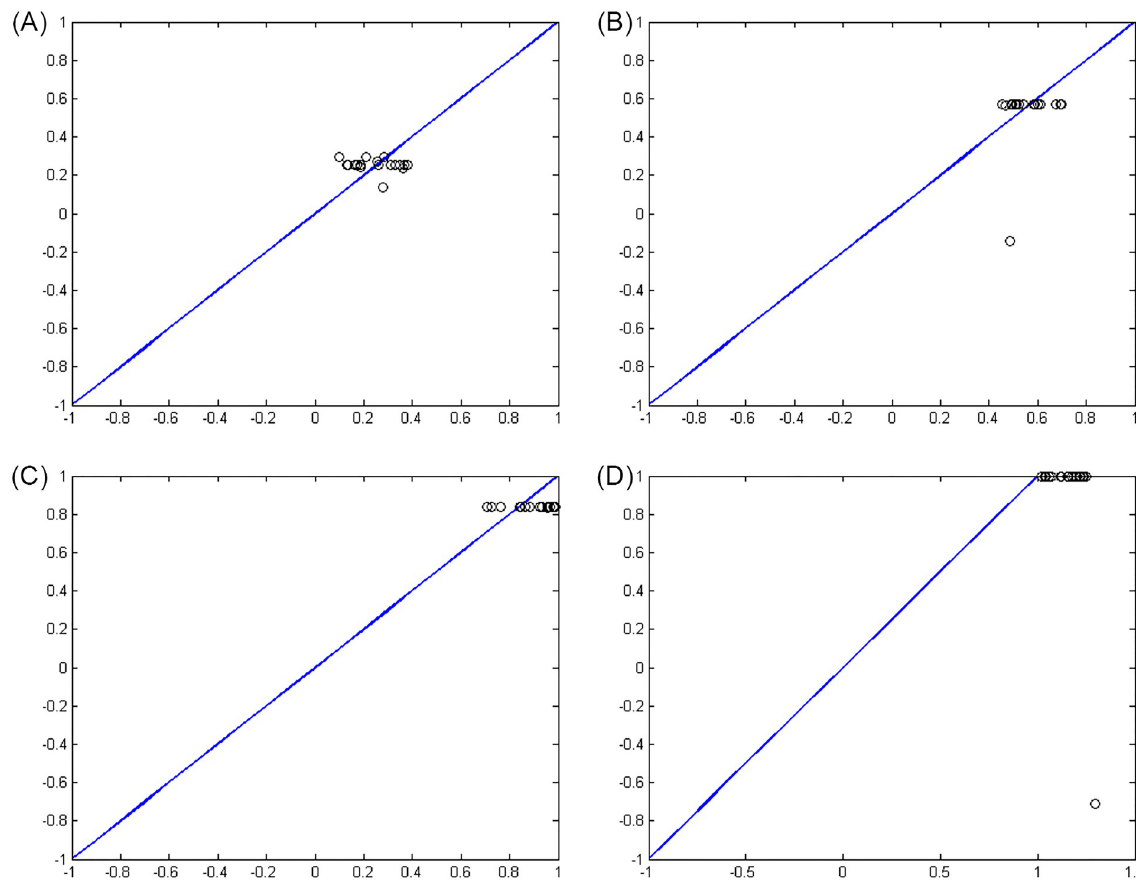
Fig 10. The distance between the real answers and the regression line (regression function) obtained with ANN-PSO in the test samples: (Fig 10A)[0.1, 0.4], (Fig 10B)[0.4, 0.7], (Fig 10C)[0.7, 1] and (Fig 10D)[1, 1.3] range.